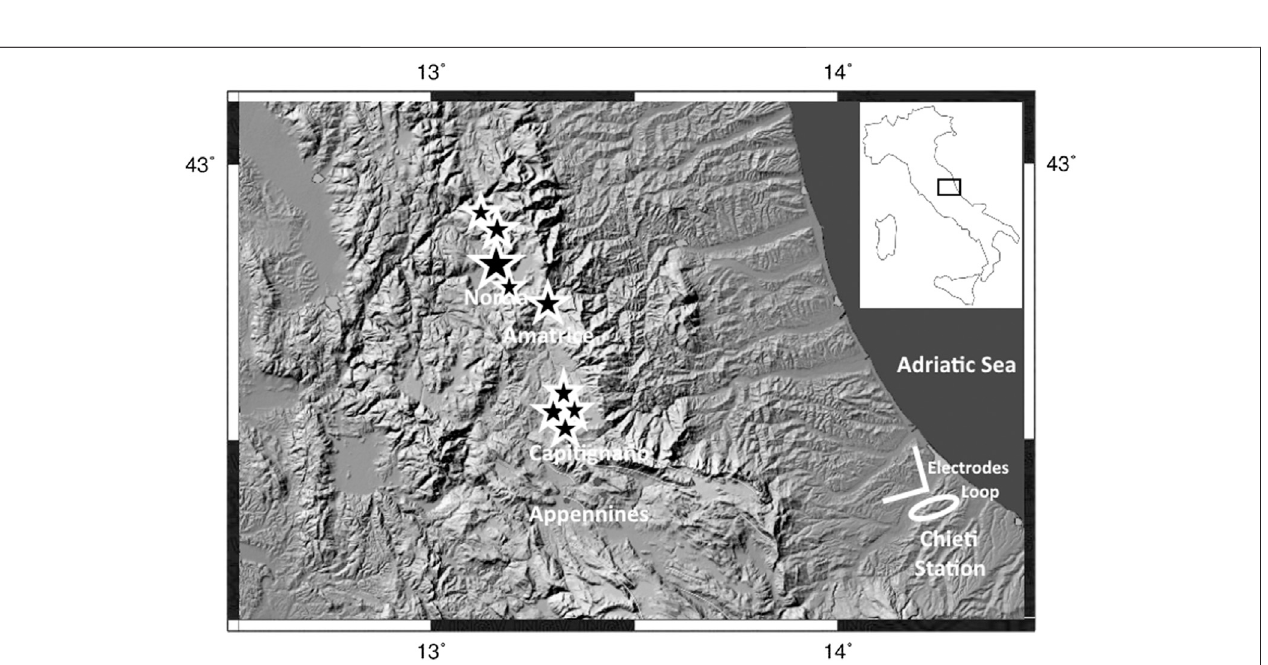
FIGURE1| The fi gureshowstheazimuthofthemagneticantenna,whichwasorientedmainlytoreducethe50 Hznoisecomingfromthelocalelectricalpowerline asfaraspossible.Furthermore,thedirectionsofwireelectrodesareindicatedbywhitesegments.TheyarelocatedinChieti,about70 – 100 kmfromtheareasofthemain shocks (stars).